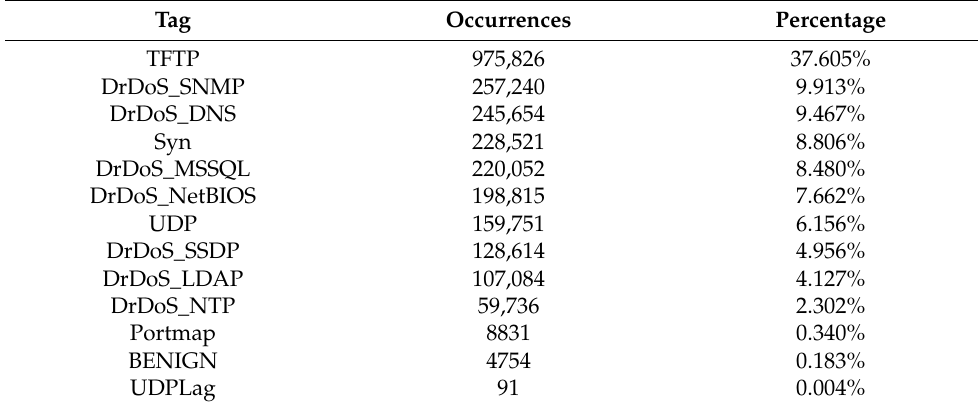
Table 1. Distribution of labels in the loaded